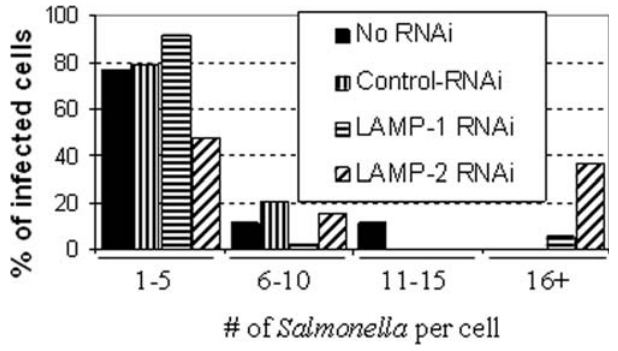
Figure 4. LAMP-1 depleted Salmonella in LAMP-2 knockdown cells proliferate at an accelerated rate. Bar plot shows the number of Salmonella per infected cell. HeLa cells were transfected with RNAi oligos to knockdown LAMP-1 or LAMP-2. 48 hours after RNAi treatment, the cells were infected with GFP- Salmonella for 6 hours, then fixed and immuno-stained. The amount of bacteria per infected cell was counted and the results shown here. The cells that contained more than 20 bacteria were the ones in which the Salmonella were not contained in LAMP-1 vacuoles.